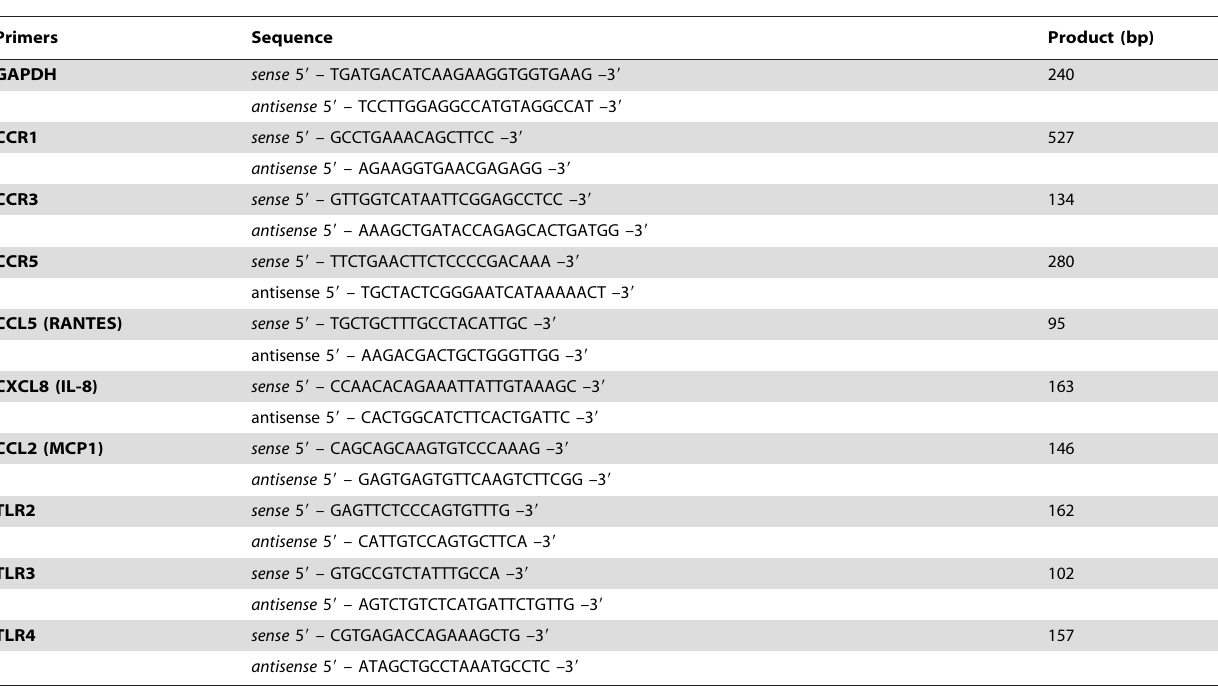
Table 1. Sequence of the primers